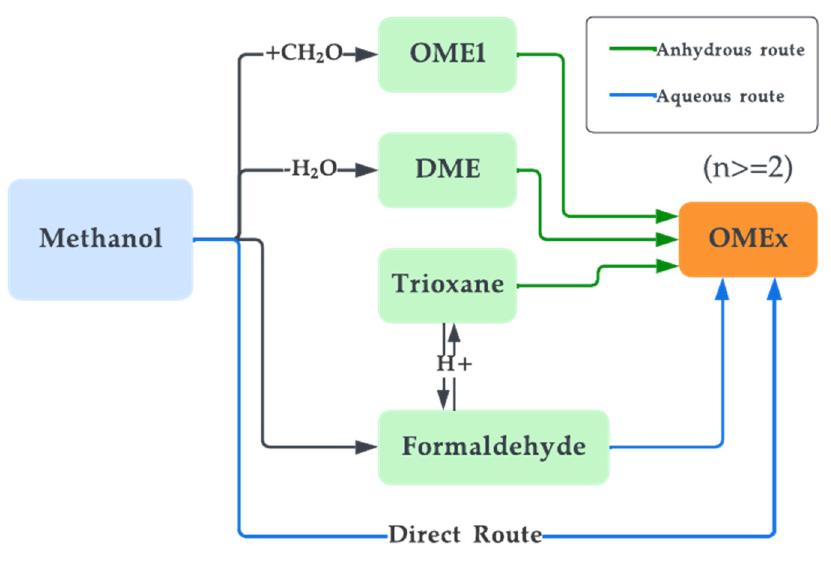
Figure 13. OMEx synthesis routes.